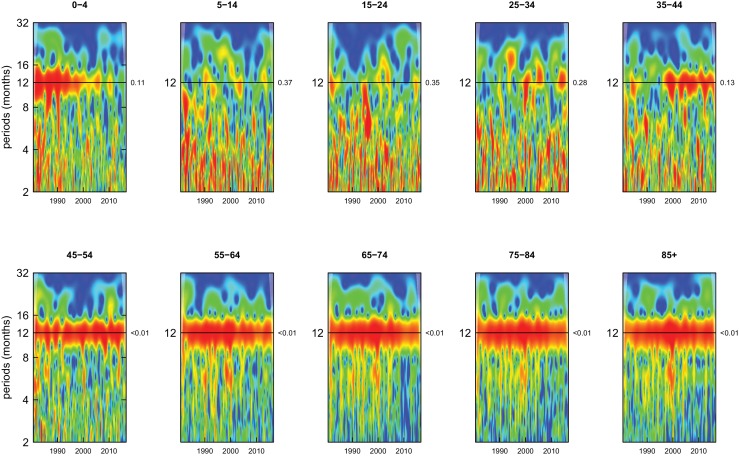
Wavelet power spectra for national time series of chronic respiratory disease death rates for 1980–2016, by age group for males.Wavelet power values increase from blue to red. The shaded regions at the left and right edge of each box indicate the cone of influence, where spectral analysis is less robust. P-values for the presence of 12 month seasonality are to the right of each figure at the 12 month line.